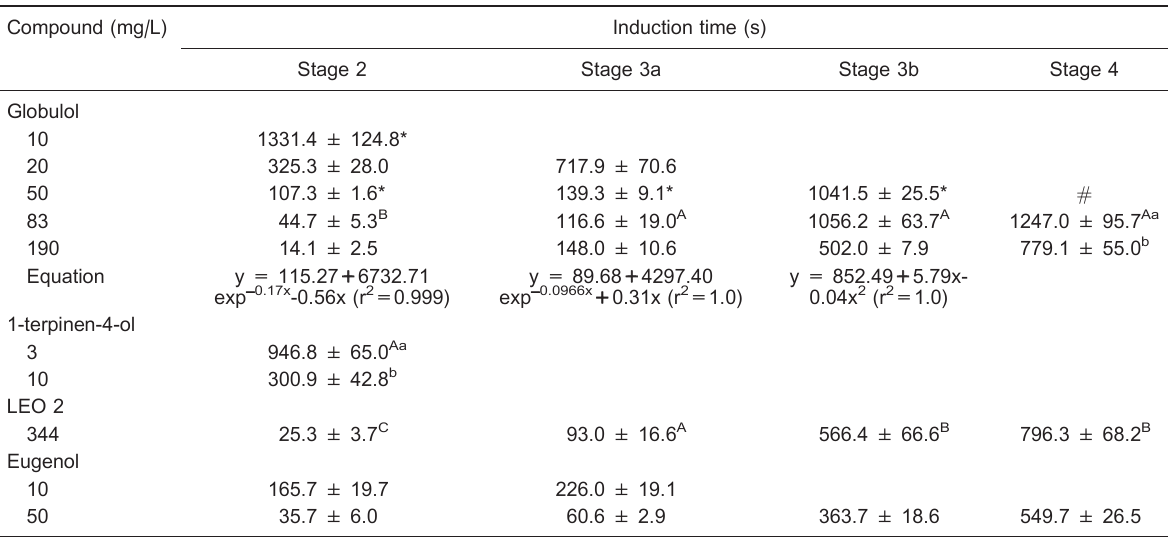
Table 2. Time required for induction of anesthesia in silver catfish juveniles with globulol and 1-terpinen-4-ol, in comparison with EO of Hyptis mutabilis (LEO 2) and eugenol (positive control). Compound (mg/L)